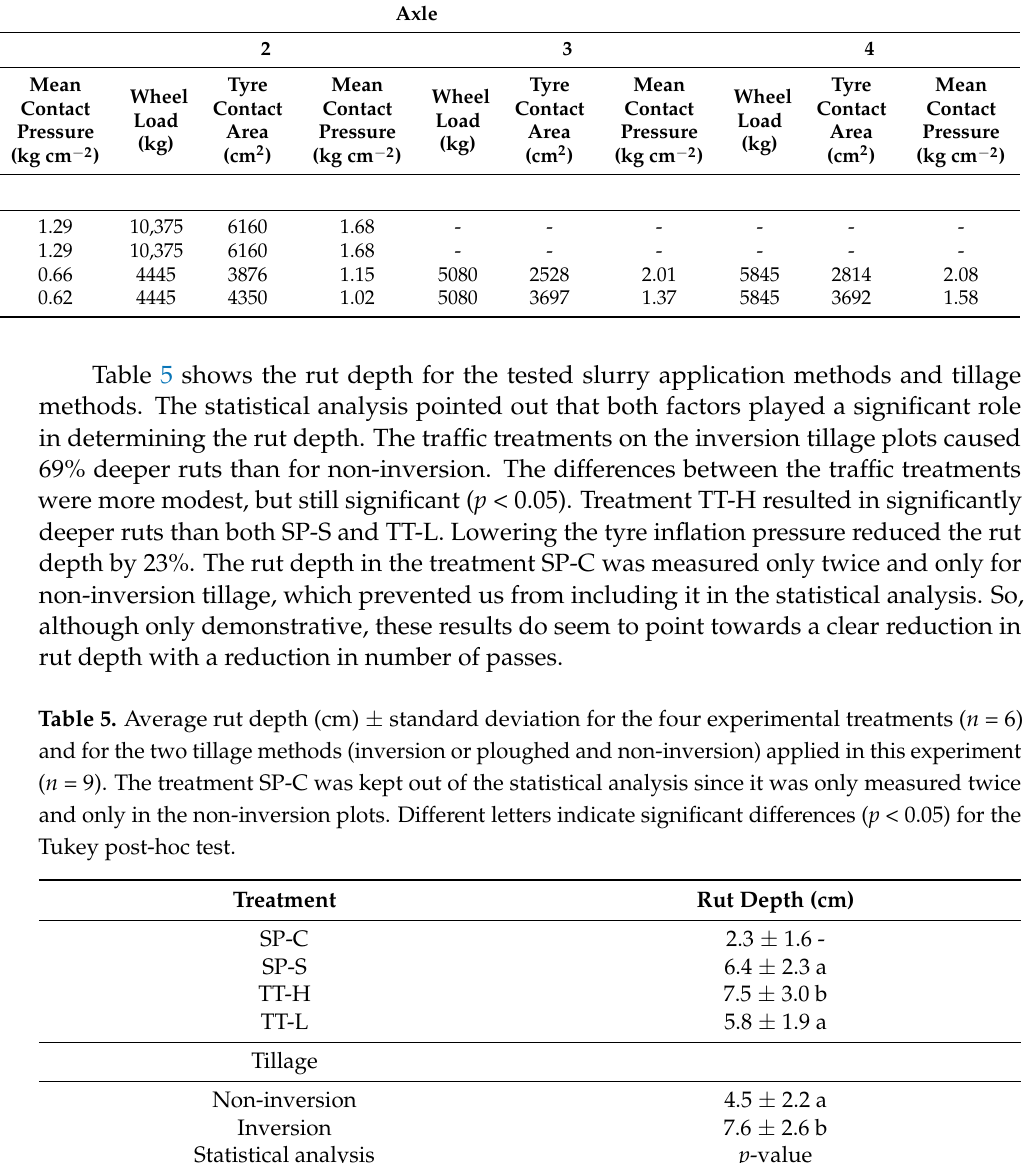
Table 4. Wheel load (kg), tyre contact area with the soil (cm 2 ) and the resulting mean contact pressure (kg cm − 2 ) for all axles of the four experimental treatments ( n = 1). The numbering of the axles is given from front to rear, as shown in Table 2. Axle